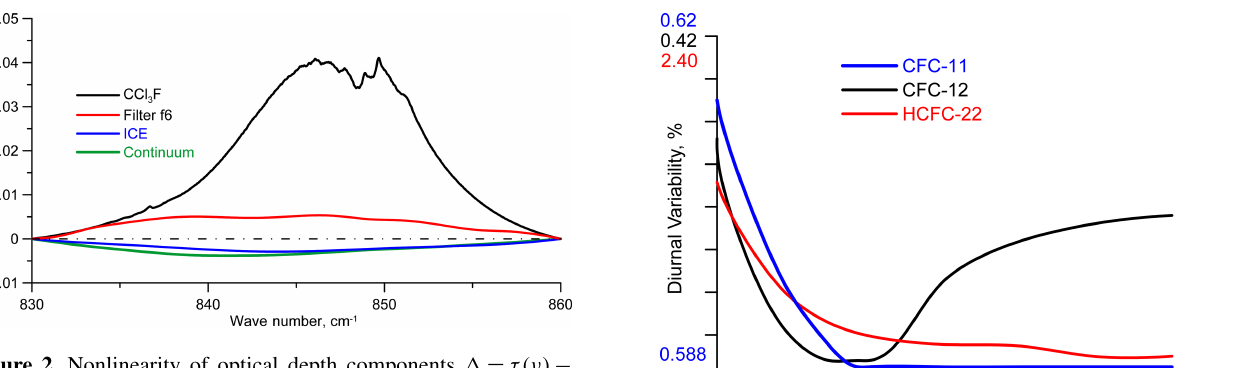
Figure 2. Nonlinearity of optical depth components (cid:49) = τ(ν) − (τ 830 + (τ 860 − τ 830 )(ν − 830 )/ 30 ) . As on 29 July 2018, where the solar zenith angle is 60 ◦ .